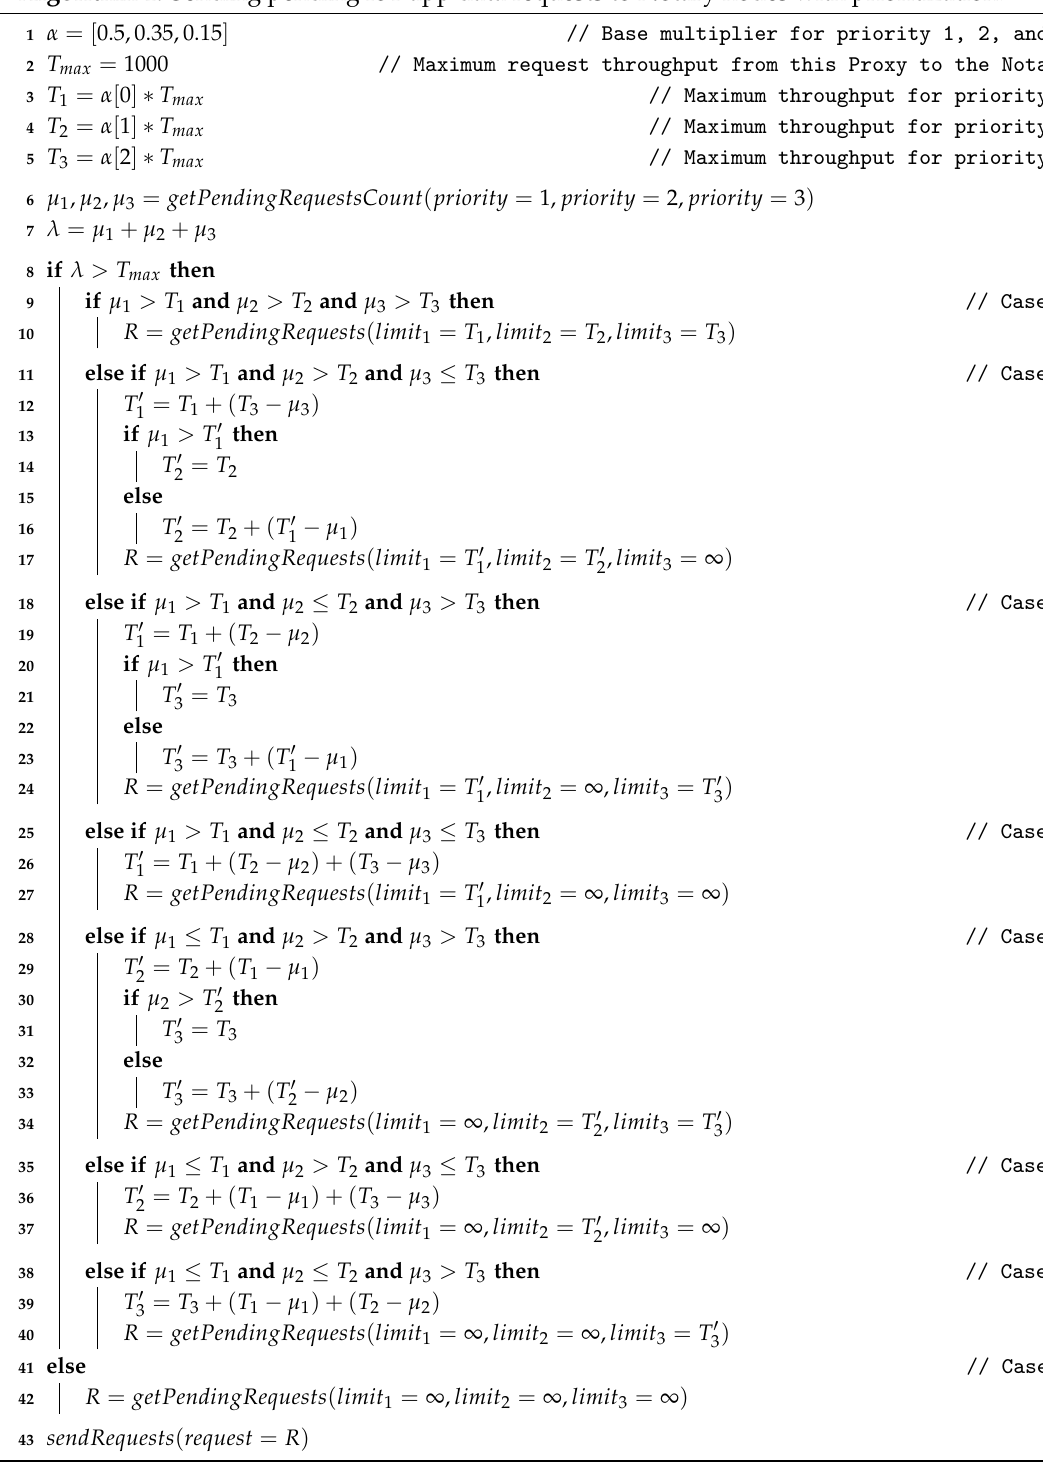
Algorithm 1: Sending pending IoT app data requests to Notary nodes with